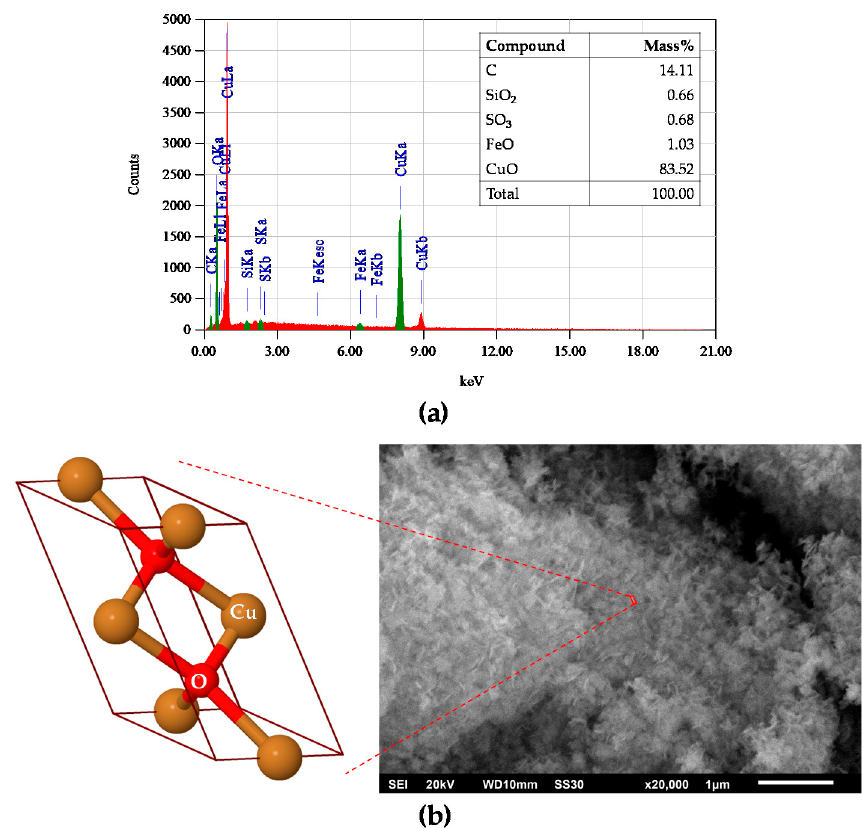
Figure 4. Composition of metal oxide in the solid product ( a ) and surface morphology (right) and crystal structure model (left) of the solid product ( b ).